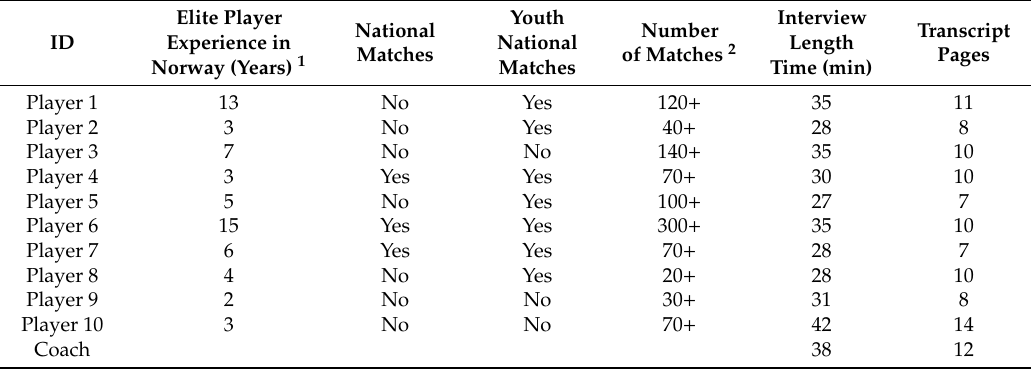
Table 1. Participants’ experience, number of national and youth matches, interview length, and number of transcriptase